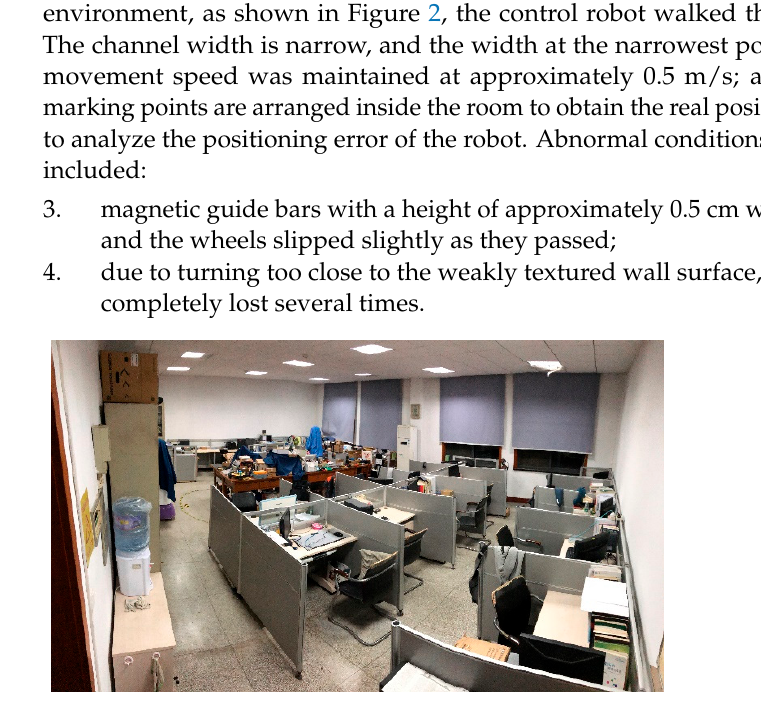
Figure 3. RViz interface at the end of test data playback. The path diagrams of pose measurement, as shown in Figure 4, start along the posi- tive X-axis. Therefore, the distance between the start point and end point shows the ex- perimental accuracy. Throughout the experiment, the car traveled for 184.3 s, the average speed was 0.264 m/s, the maximum speed was 0.591 m/s, the cumulative translation was 51.321 m, the cumulative rotation was 3428.318°, and the chassis had no abnormalities. As this experiment was performed in an actual scene, the experimental system did not have the equipment to measure ground truth; therefore, it could only measure the distance er- ror of the car passing several fixed road marking points. In each experiment, the robot was controlled to accurately pass the road marking point and keep the rotation direction con- sistent. Therefore, the pose error in Table 1 is average position error and yaw angle error among several road marking points. When the robot passes through each road marking point, a timestamp is marked. Calculate the coordinate error ( ∆ X and ∆ Y ) , position error ( ∆ P(m), absolute value), and yaw angle error ( ∆ A) between the algorithm trajectory pose and the road marking point when it is at the time stamp. For each algorithm, take the average of the errors generated by all road marking points as the final experimental result. The position error rate ( ∆ P(%)) is the ratio of the position error to the cumulative transla- tion. The table shows our algorithm performed best, with and without closed loops. The position error was 0.206 m and 0.015 m, respectively. As shown in Figure 4, we can clearly see the error of the different methods.